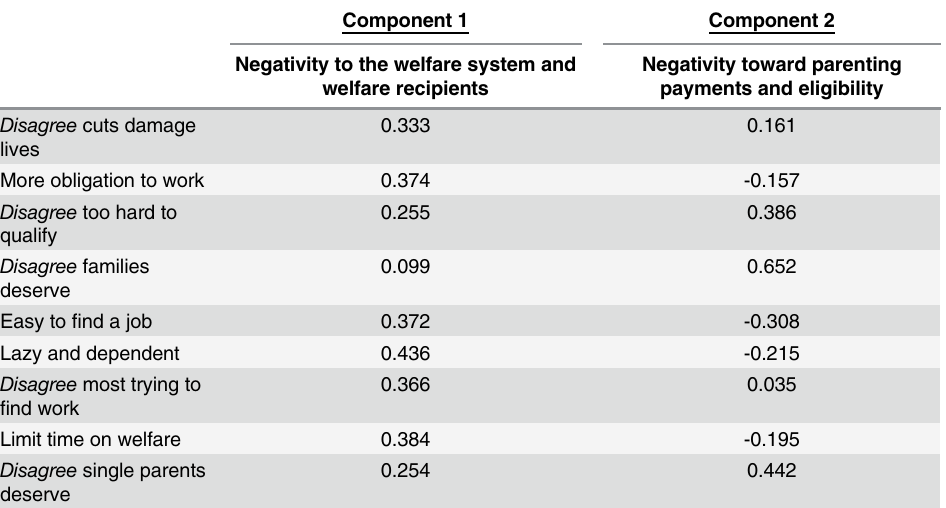
Table 4. Results of Principal components